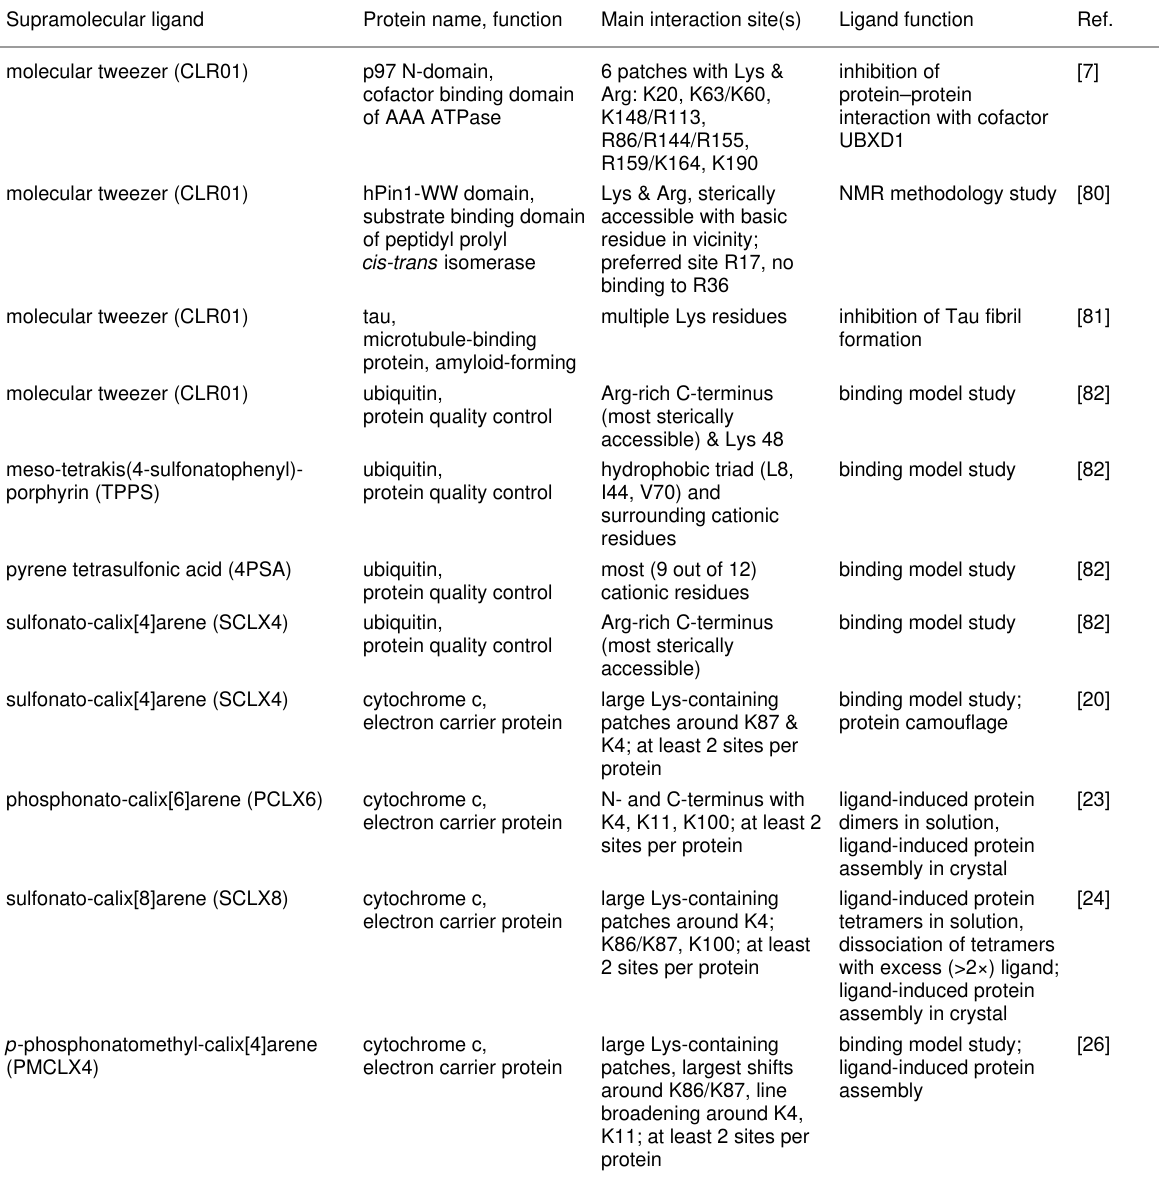
Table 1: Summary of NMR studies on supramolecular ligands binding to protein surfaces. Supramolecular